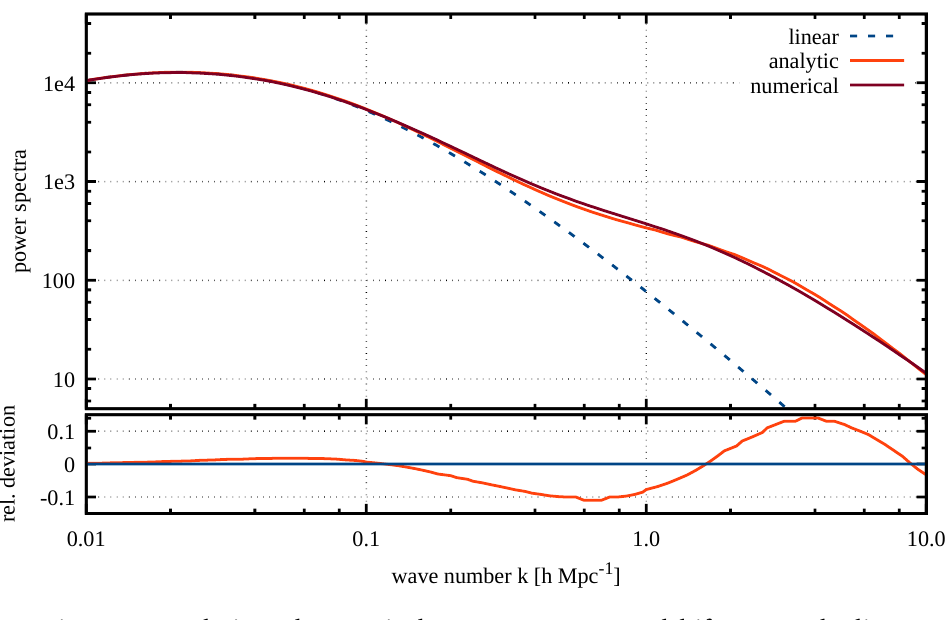
Figure 2: Analytic and numerical power spectra at redshift z = 0. The linear power spectrum is taken from [ 12 ] , the numerical spectrum from [ 10 ] . The flat lower panel shows the relative deviation between the analytic and the numerical power